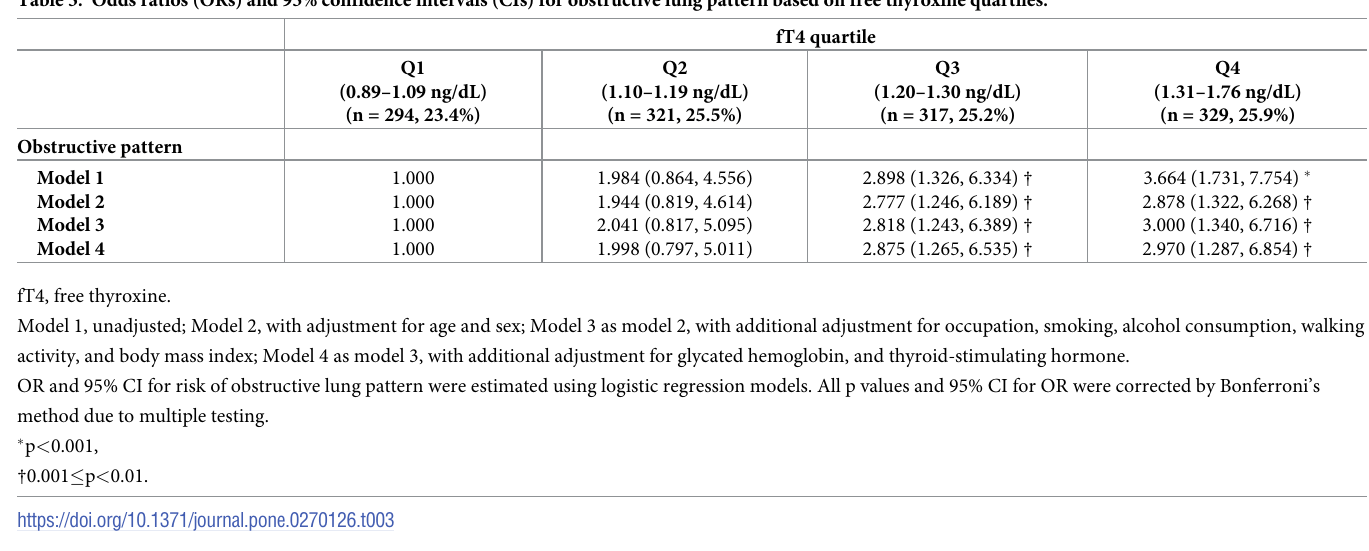
Table 3. Odds ratios (ORs) and 95% confidence intervals (CIs) for obstructive lung pattern based on free thyroxine